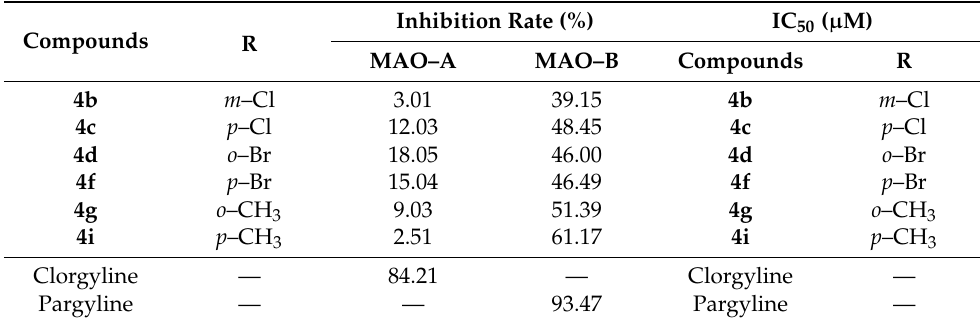
Table 2. Test results of inhibitory activity of benzothiazole–isoquinoline derivatives on monoamine oxidase A (MAO–A) and MAO–B.